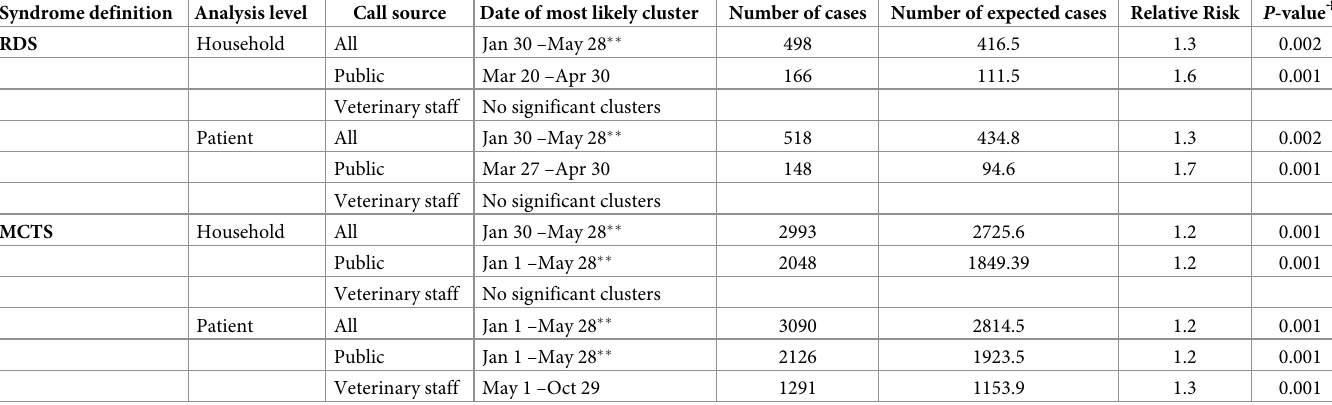
Table 6. Results of month-adjusted 1 retrospective temporal scan statistics using a Poisson model examining renal dysfunction syndrome (RDS) and melamine- cyanuric acid toxicosis syndrome (MCTS) calls involving dogs and cats to the APCC 2 (January 1 –December 31, 2007). Syndrome definition Analysis